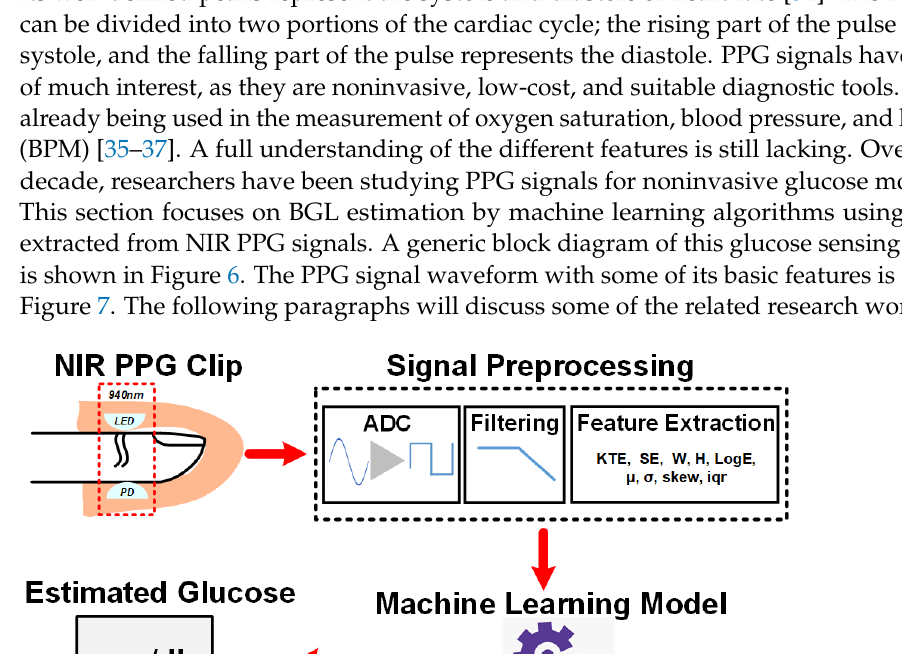
Figure 7. PPG waveform and its basic features. Monte-Moreno’s study [38] is one of the initial works which investigates noninvasive BGL estimation using PPG signals with machine learning algorithms. This system also measures blood pressure and heart rate using the same recorded PPG signals, and 410 individual data are recorded. The designed module also mitigates motion artifacts and rejects noisy recorded signals. After signal processing, main features are extracted, and a feature vector of fixed length is formed. This feature vector is input into the machine learn- ing module. The PPG signals are recorded for a 1 min duration. Each signal is segmented into overlapping frames of length 5 s. Both segmented and unsegmented signals are input to the feature extraction unit. The statistical features extracted from input signals are mean, variance, skewness, and interquartile range (IQR) of Kaiser Teager Energy (KTE), heart rate (HR), spectral entropy (SE), IQR, and variance of Log Energy (LogE) profiles. Autoregressive (AR) coefficients of order 5 from the PPG waveform, KTE, and LogE are also computed. Other non-statistical features include oxygen saturation range (OSR), age (AG), weight (WGT), and body mass index (BMI). The feature vector (XF) is formed by concatenating all the features. This feature vector is input to the machine learning module. In total, a 33-dimensional feature vector is formed from 20 distinct features given by: